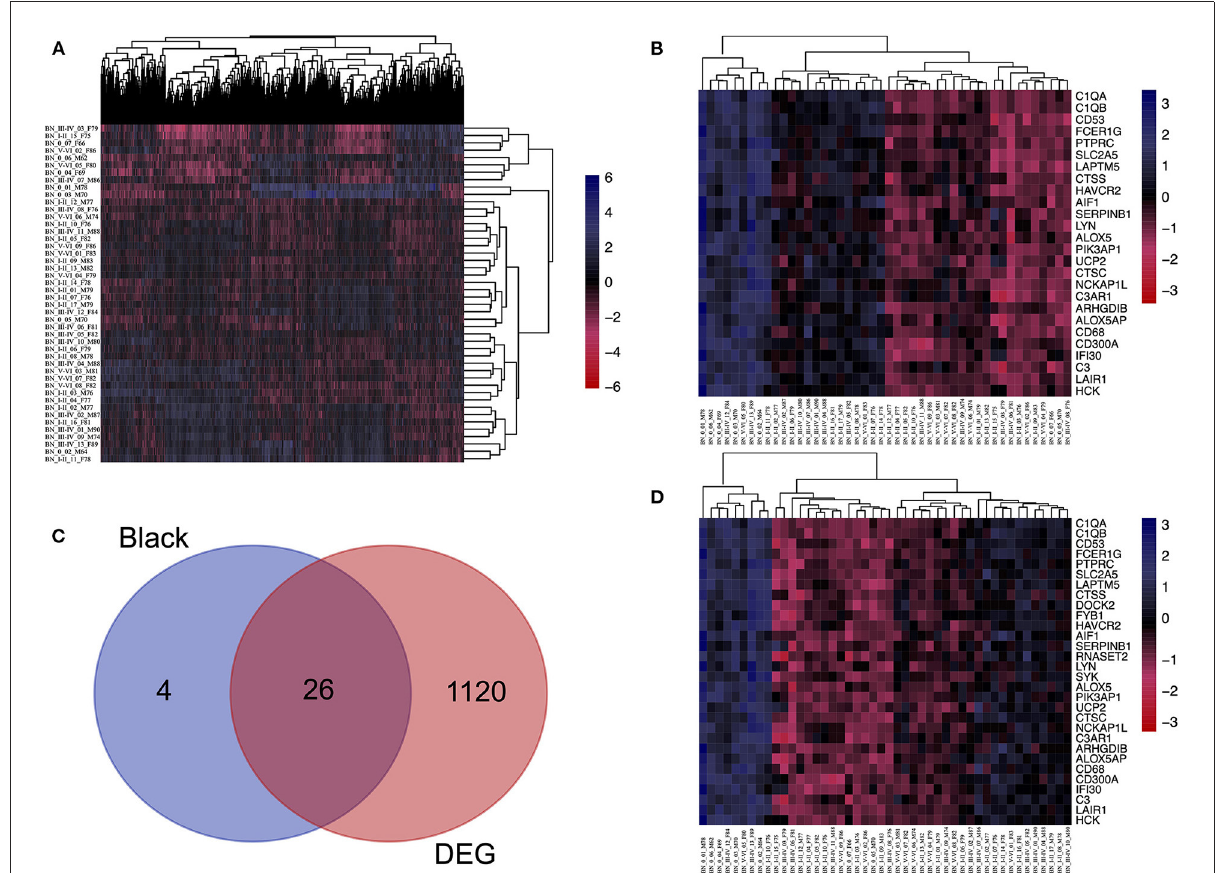
FIGURE3 Identifying the overlapping genes between downregulated DEGs in the aged group and genes in the black module. (A) Heatmap of the expression of DEGs. (B) Heatmap of the Top30 gene expression in the black module. (C) Using veen tools to find the overlap genes between downregulated genes in DEGs and genes in the black module. (D) Heatmap showing the expression of the overlapping genes in different